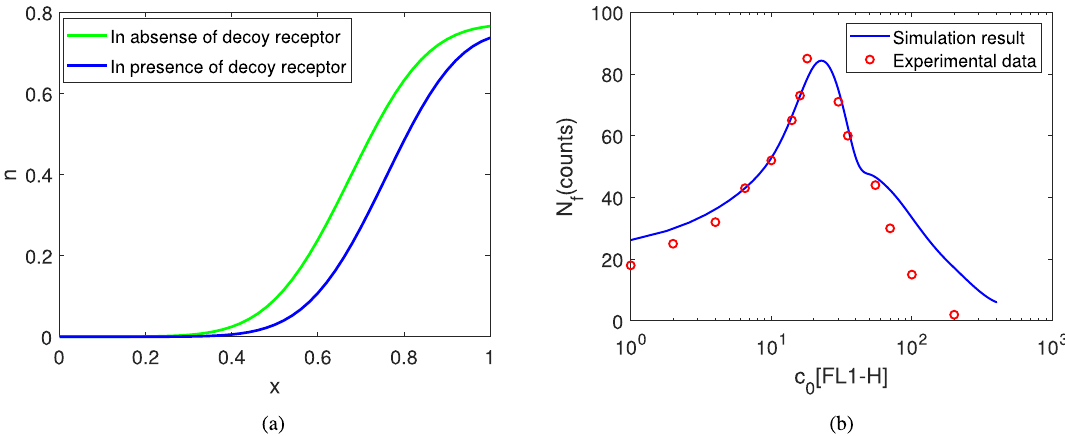
Figure 6. ( a ) Comparison of cell migration in presence and absence of decoy receptors at t = 5 . Here β = 0.97 and δ = 0.952 in presence of decoy receptors and β = 0.97 and δ = 0 in absence of decoy receptors. ( b ) Cell count in the filter for different initial cell concentrations at time t = 5. Here n 0 = 5 × 10 δ = 0.952 . Experimental data is collected from Fig. 3B 8 , LN-229 cell in presence of decoy receptor DcR3. All other parameter values for ( a ) and ( b ) are given in Table